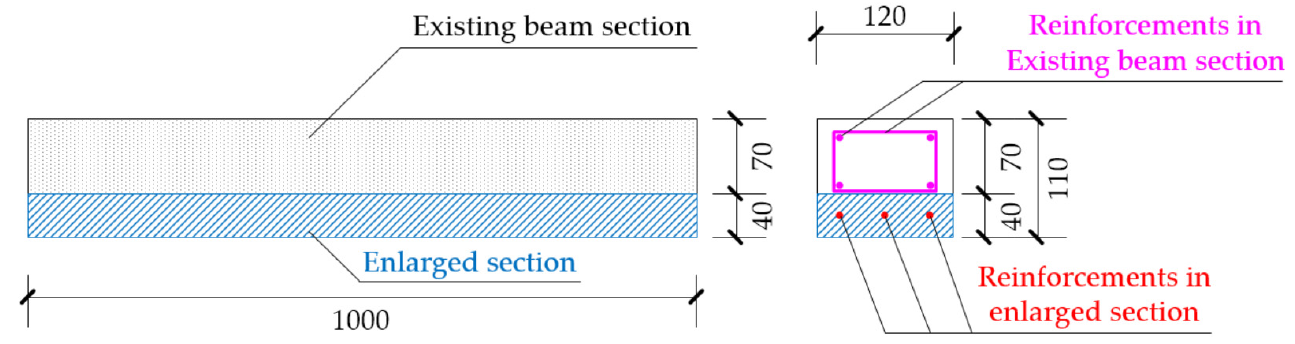
Figure 1. Specifications of the test specimens. Table 1. The design parameters of specimens.